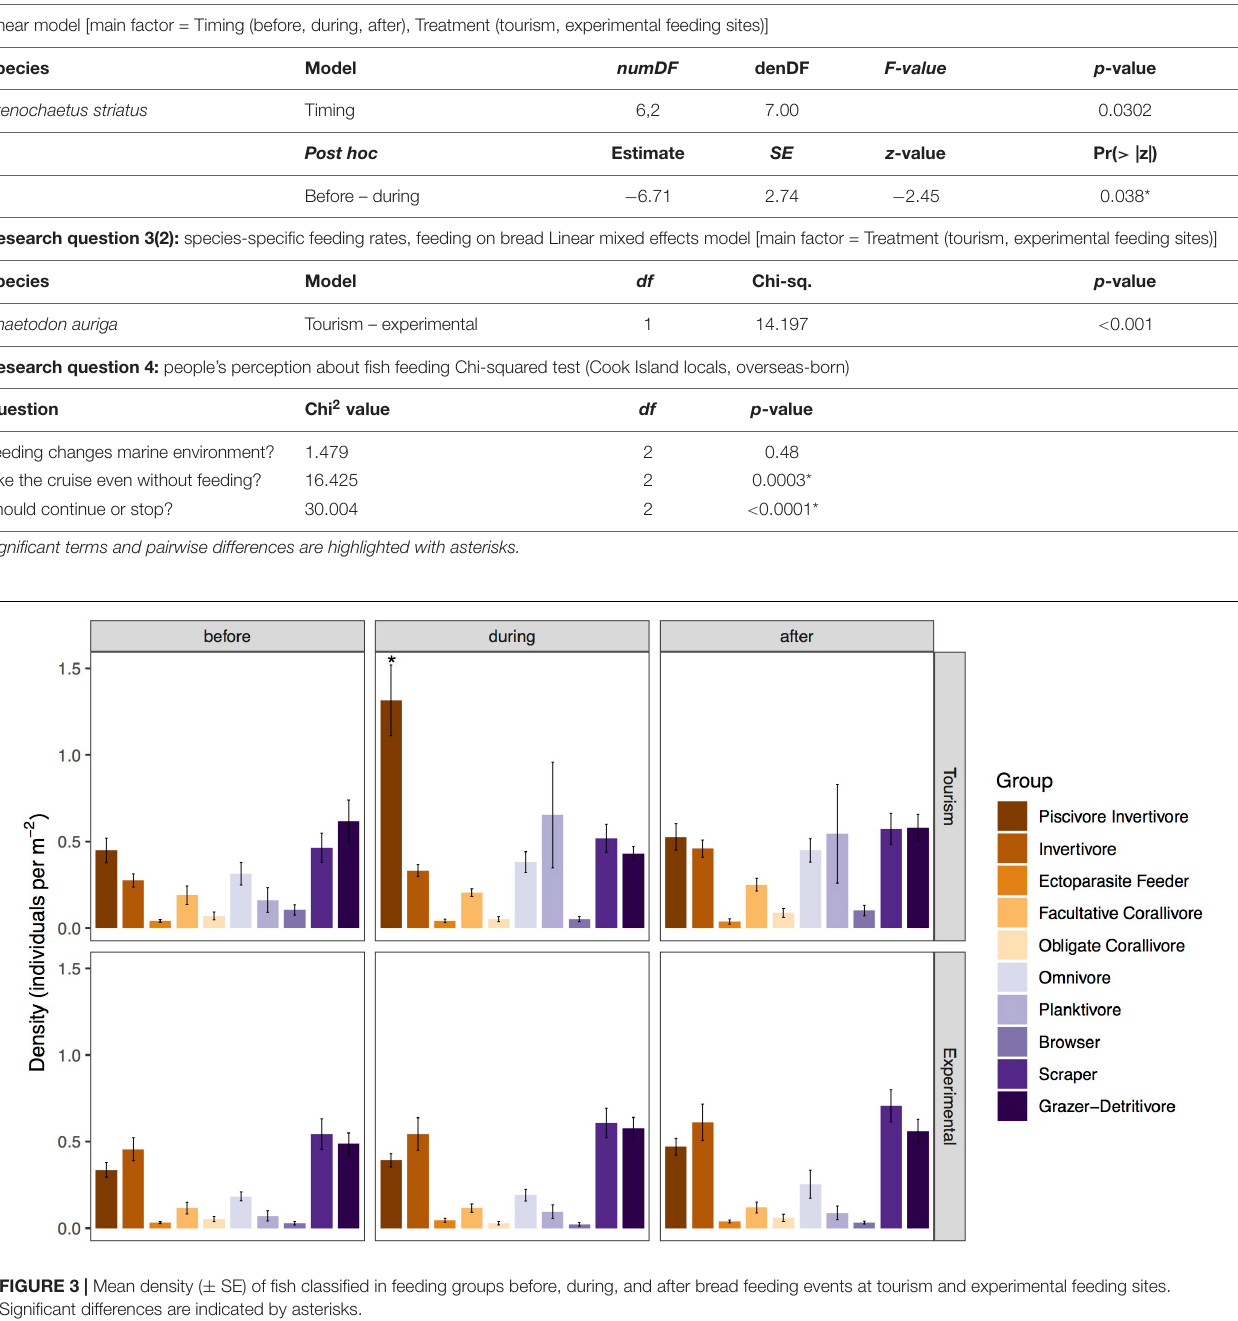
Frontiers in Marine Science |